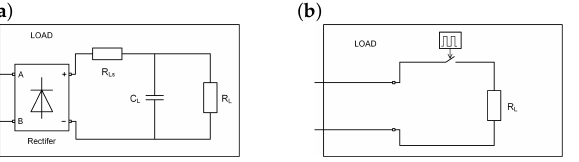
Figure 4. ( a ) Schematic diagram of the rectifier RC load, ( b ) abruptly changing resistive load. According to [7,28,29,31], the parameters for th rectifier load in ( a ) are R Ls = 1 Ω , C L = 430 µ F, R L = 100 Ω . For the abruptly changing resistive load in ( b ) there is R L = 500 Ω . R L is periodically turned on when the reference sine wave V m sin ( ω t ) = 0, and off when it reaches V m or − V m